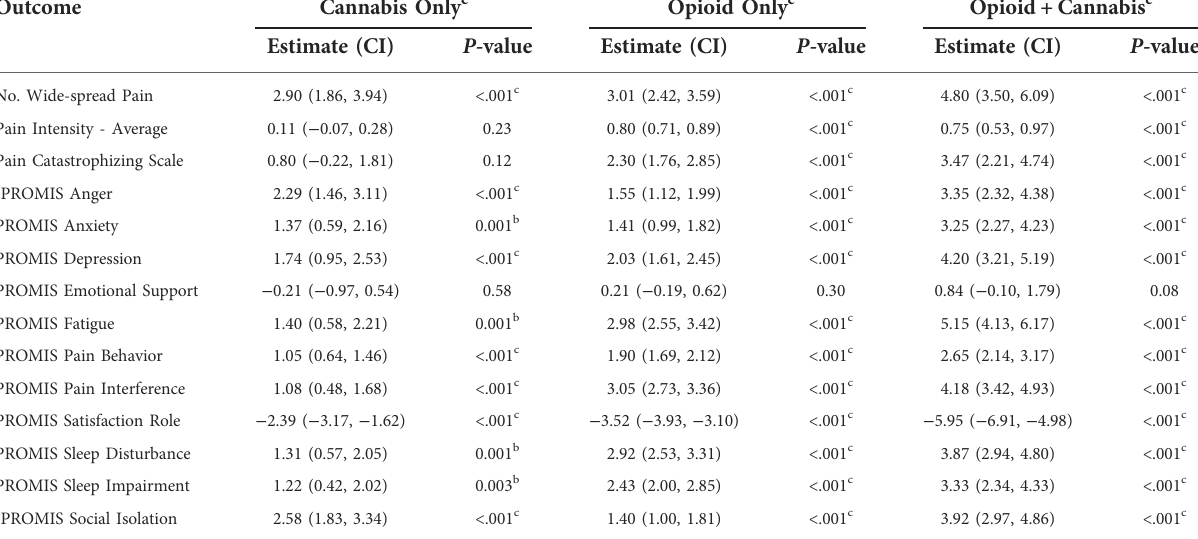
TABLE 2 Differences in pain intensity, body Map areas and PROMIS measures by cohort a .